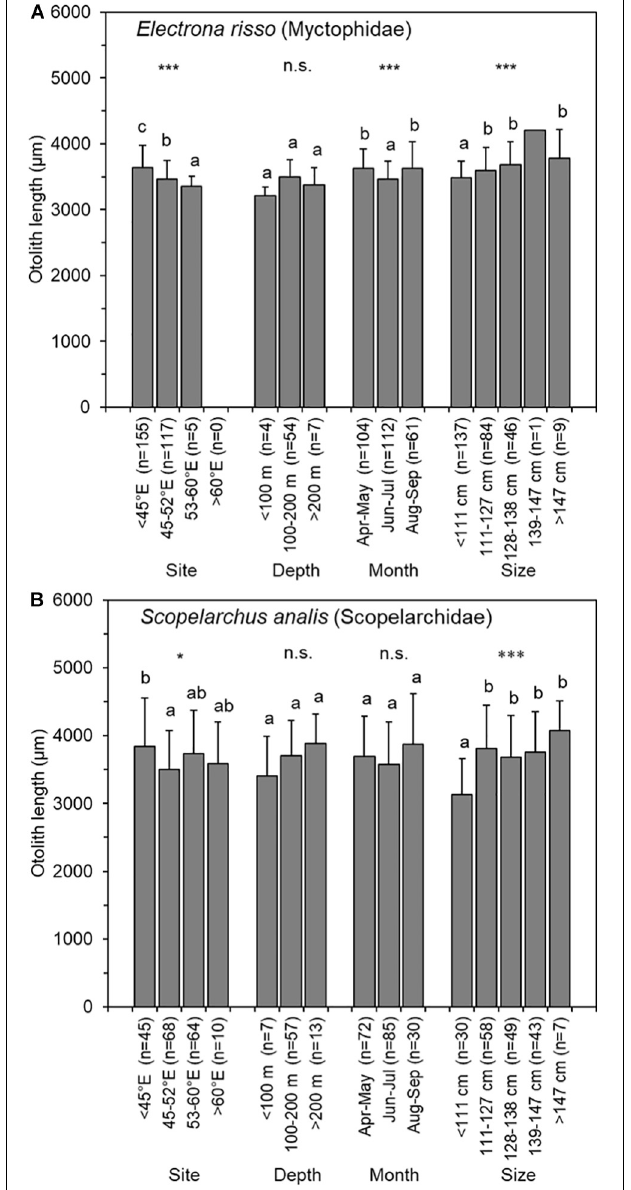
FIGURE 7 | Means and standard deviations (vertical lines) of prey otolith length of (A) Electrona risso (Myctophidae) and (B) Scopelarchus analis (Scopelarchidae) in 78 otolith-containing stomachs of bigeye tuna ( Thunnus obesus ) by capture site, depth, month, and fish size. The asterisks indicate levels of significance: *0.05, ***0.001; n.s., not significant. The same letter indicates that otolith lengths were homogeneous among the groups.